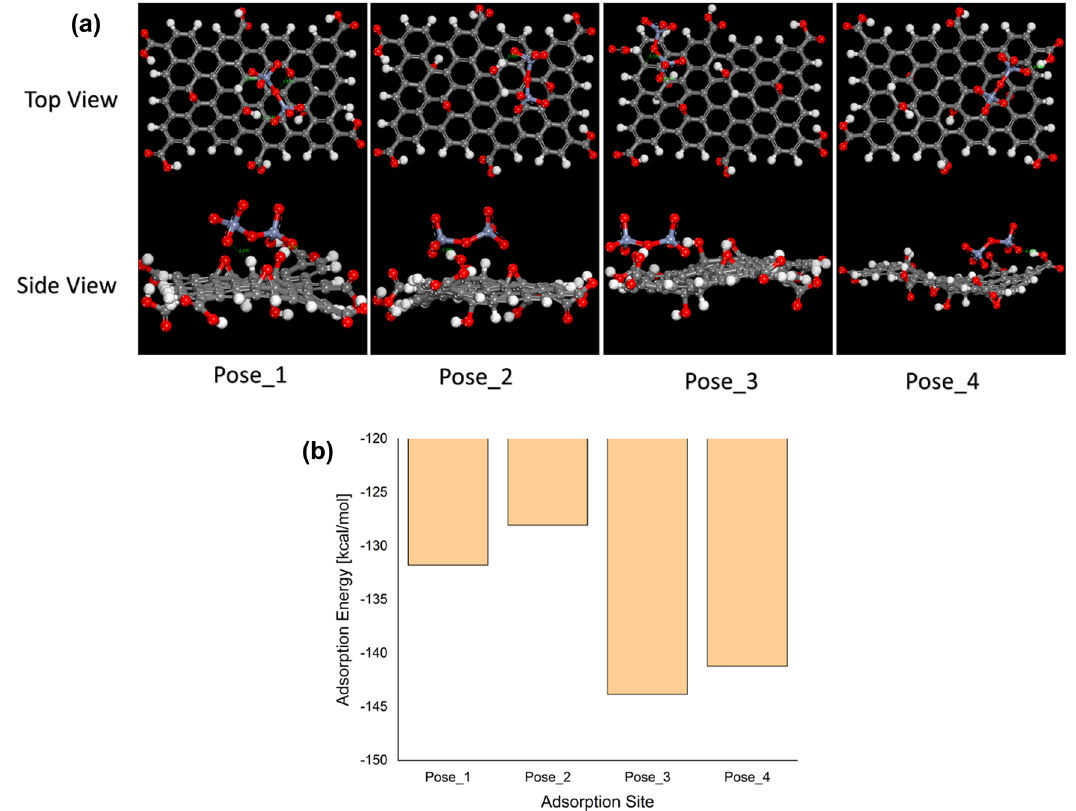
Figure 3: ( a ) Four di ff erent explored adsorption sites for the dichromate ion on the GO surface ( the GO model is approximated by using a 5 × 5 graphene model that contains epoxy, hydroxyl, and carboxy groups on its surface ) ( level of theory: GGA/PBE/DFT - D = TS [ Tkatchenko and Sche ffl er ] //TNP – triple numerical polarized basis set; basis fi le: 4.4 ) and ( b ) the corresponding adsorption energy values.